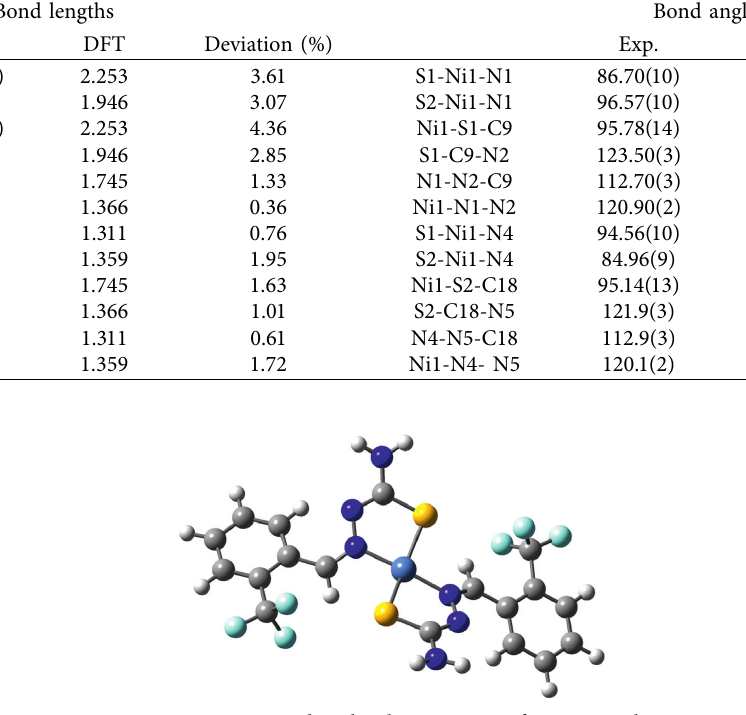
2 complex (50% probability